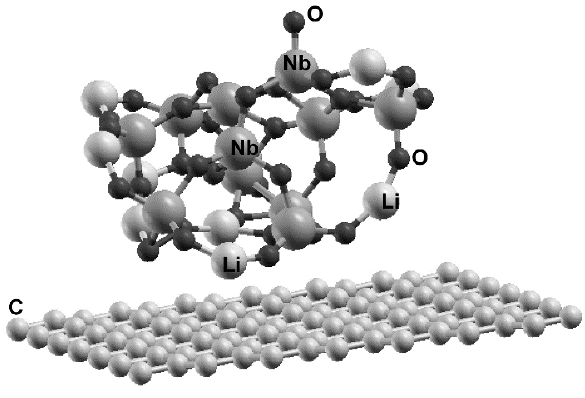
Figure 1. We show the unit cell with the final configuration of the lithium cluster adsorbed on the graphene layer. The cluster has 11 molecules. This means 11 lithium atoms, 11 niobium atoms, and 33 oxygen atoms. The unit cell of graphene has 98 carbon atoms.